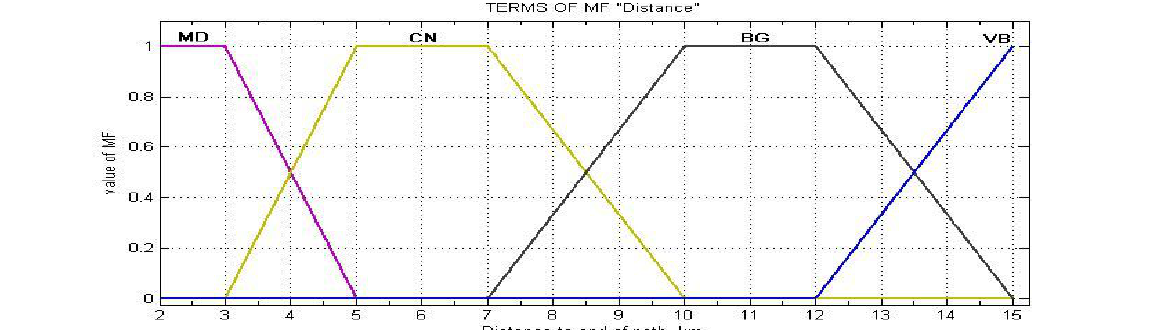
Figure 5. Term-sets MD, CN, BG, VB of linguistic variable “Distance”